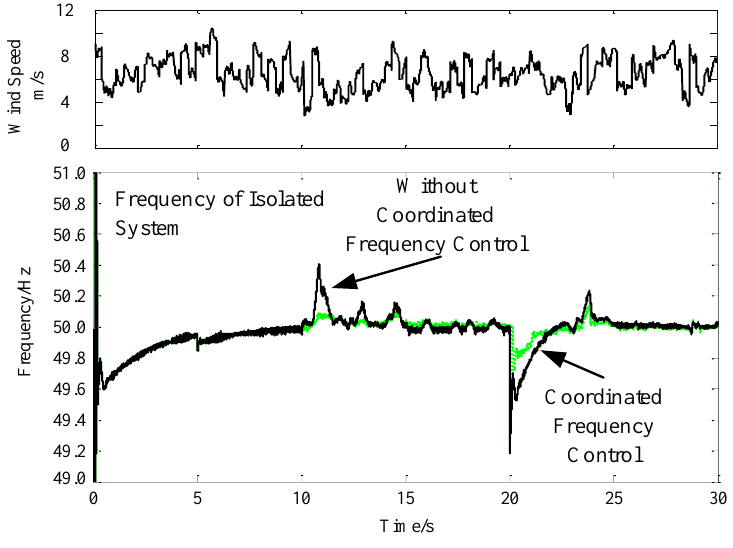
Figure 12. Simulation results under variable wind speed.